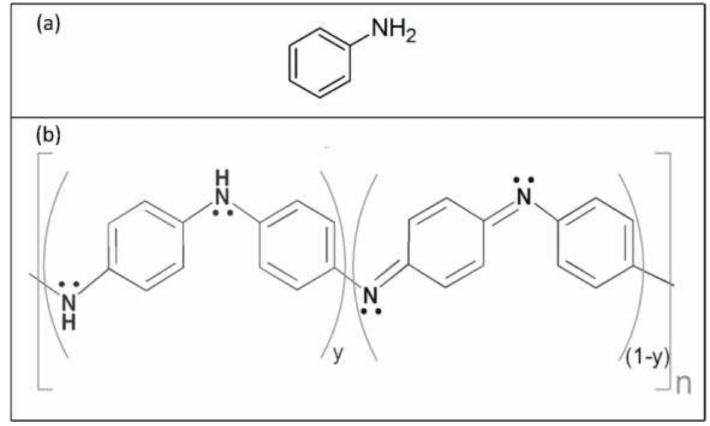
Figure 1. ( a ) Aniline structural formula; ( b ) polyaniline structure as a repetition of y and (1-y) units. At y = 0, polyaniline is in the form of pernigraniline, the fully oxidized form; if y = 0.5, polyaniline is in the form of emeraldine, while y = 1 corresponds to the form of leucoemeraldine (the fully reduced